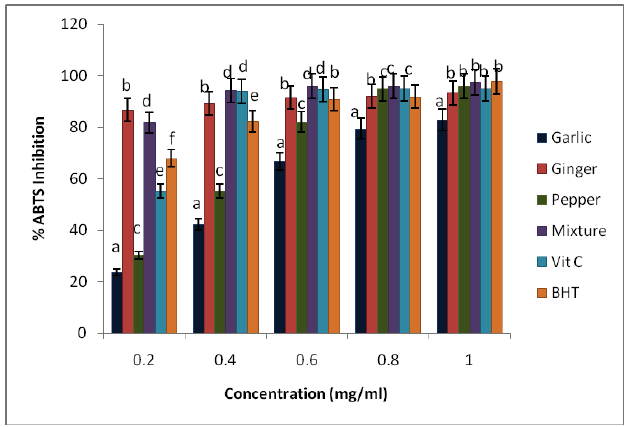
Fig. 3: ABTS activities of extracts of garlic, ginger, pepper and their mix- ture. a-f Values are means of 3 determinations ± SEM. Bars with different colours carrying different letters are significantly different (P<0.05). Vit. C = vitamin C, BHT= butylated hydroxyl anisole